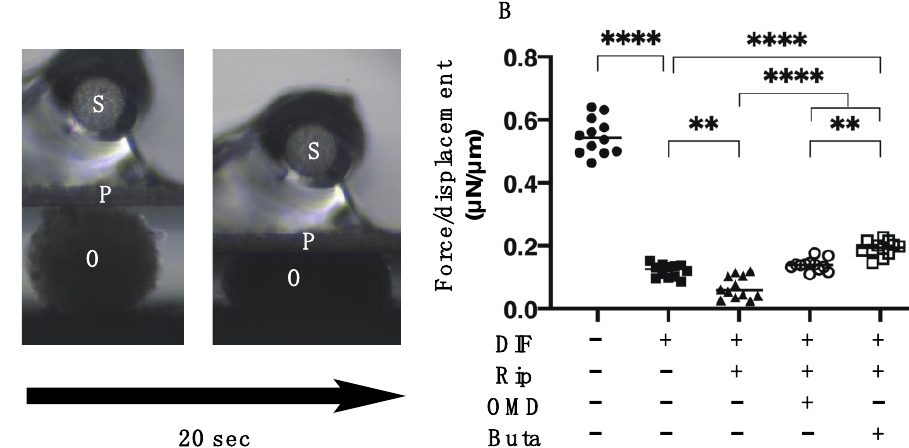
Figure 4. Additive effects of EP2 agonists to ripasudil (Rip) on the physical stiffness of 3T3-L1 3D organoids. The 3D organoids of 3T3-L1 cells were prepared under several sets of conditions: preadipocytes of 3T3-L1 cells (DIF-) or adipogenic differentiation (DIF+) with or without a combination of 10 µ M ripasudil (Rip) and the EP2 agonist, 100 nM omidenepag (OMD) or 100 nM butaprost (Buta). The specimens collected on Day 7 were subjected to a physical solidity analysis. A single 3D organoid was placed on a 3 mm × 3 mm plate and was then compressed to 50% deformation during a period of 20 s, while being continuously monitored by a microscopic camera (panel A , B : S: micro-sensor of the mechanical force ( µ N), P: compression plate, O: single 3D organoid). Among above experimental conditions, the required force ( µ N) was measured and force/displacement ( µ N/ µ m) was potted (right panel). ** p < 0.01, **** p < 0.001 (ANOVA followed by Tukey’s multiple comparison test).